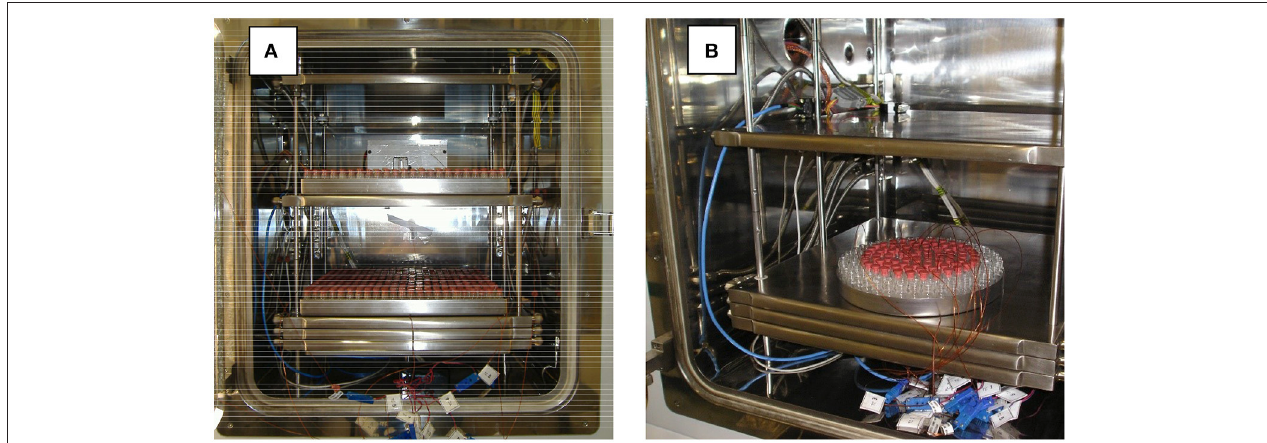
FIGURE 1 | Typical vial arrangements in a freeze-dryer, during the cycle development stage, with thermocouples inside some vials for process monitoring. The cases of large rectangular trays (A) and a smaller circular tray, with empty vials in the external rows for shielding purposes (B) , are shown.